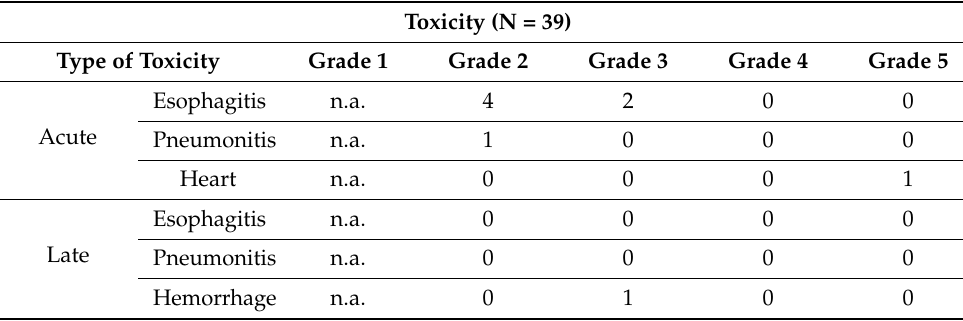
Figure 4. Impact of local control on overall survival: patients with local control above median (green) had a significantly longer OS (log-rank p -value: 0.004).